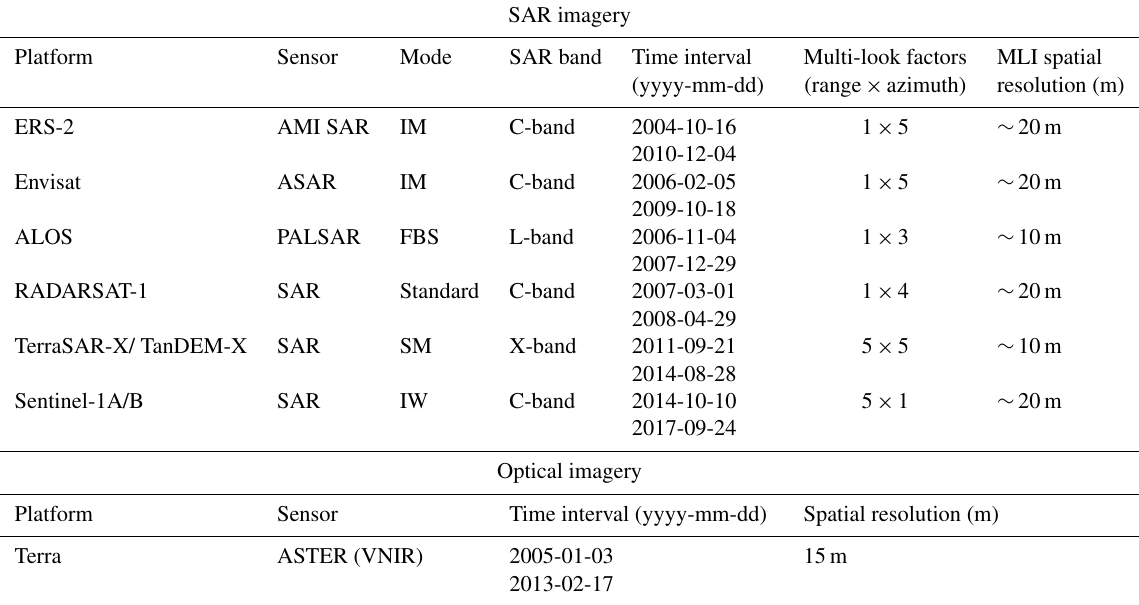
Table 1. SAR and optical satellite imagery used in this study. SAR imagery Platform Sensor AMI